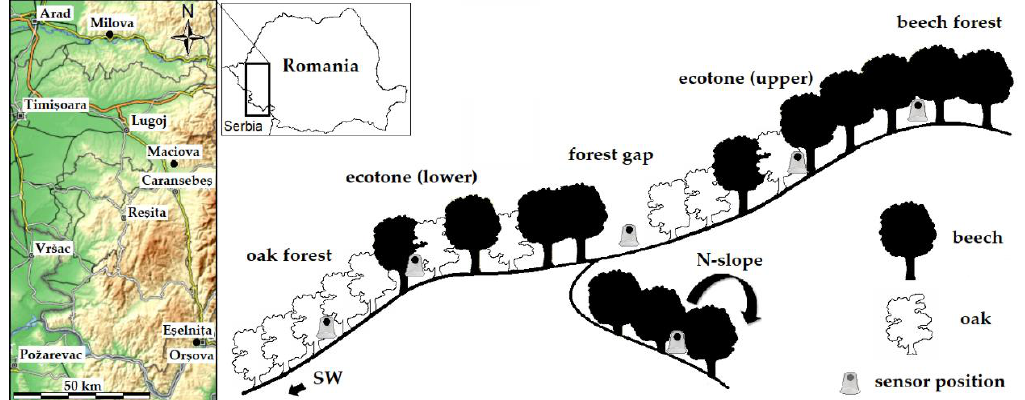
Figure 1. Study region in the western Romanian Carpathians (source OpenTopoMap, licence CC-BY-SA, slightly altered), and scheme of the transects from oak to beech forest on a south-west exposed slope. The location of microclimatic measuring points (sensor position) is indicated. Additional measuring points were established in a north-facing beech forest at mid-slope elevation and in a forest gap.